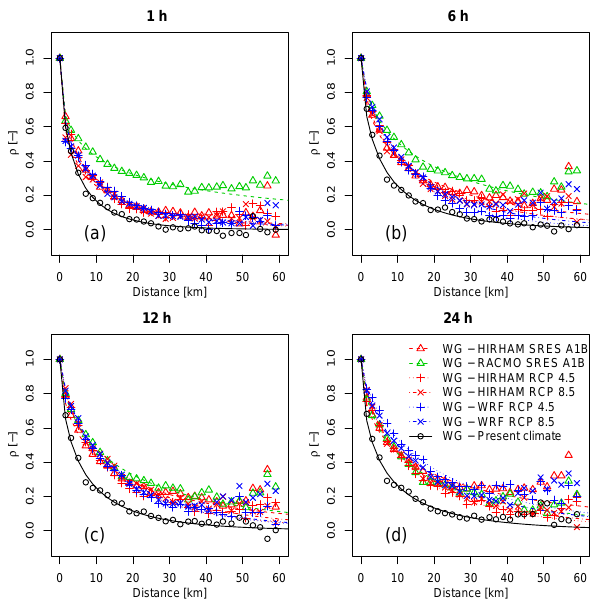
Figure 12. The unconditional spatial correlation of all T year events for perturbed WG output for event durations of 1, 6, 12, and